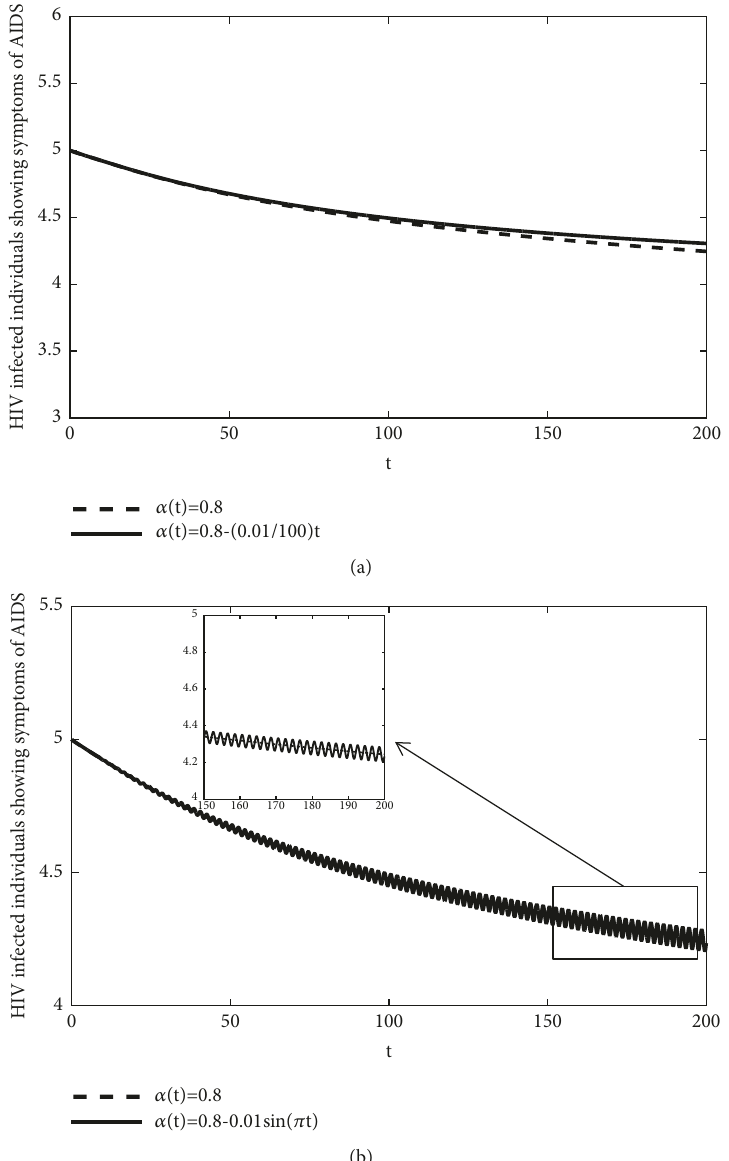
Figure 2: HIV infected individuals showing symptoms of AIDS with ] 2 = 10 . Parameters values are in Table 1 with 𝛽 ℎ = 0.01 . (a) 𝛼(𝑡) = 0.8 comparing with 𝛼(𝑡) = 0.8 − (0.01/100)𝑡 ; (b) 𝛼(𝑡) = 0.8 comparing with 𝛼(𝑡) = 0.8 − 0.01 sin (𝜋𝑡)